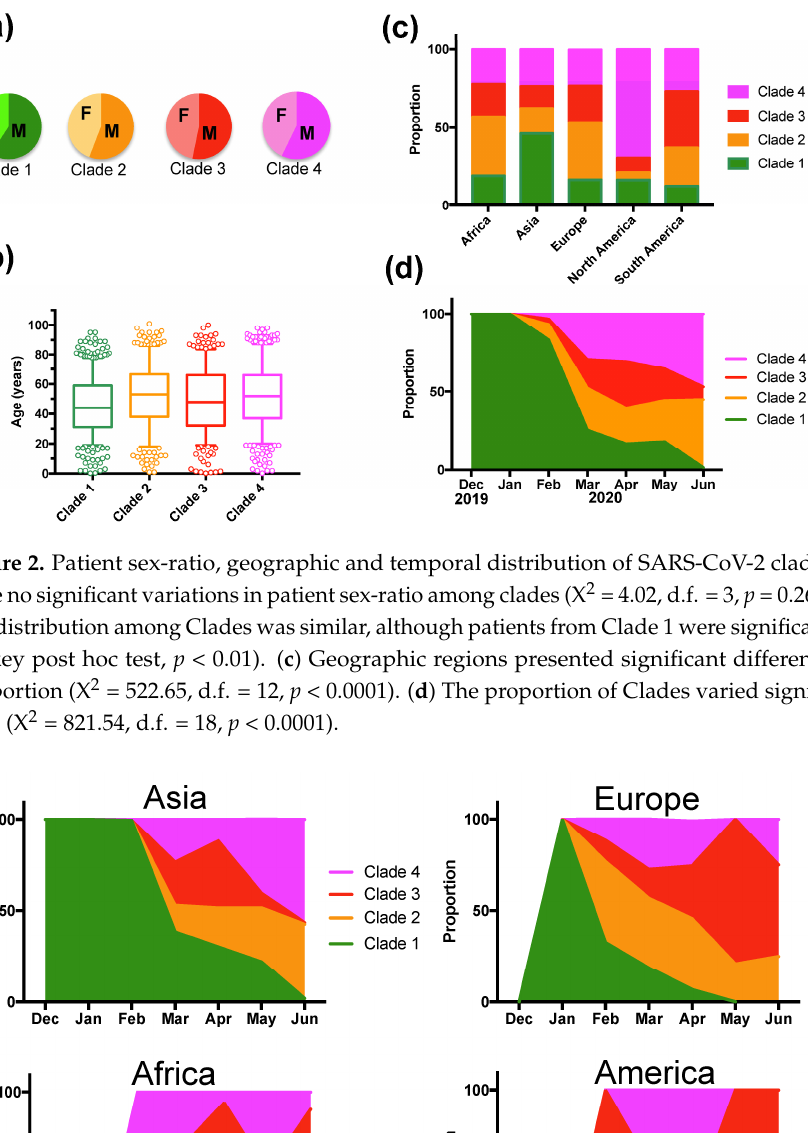
Figure 1. Genomic diversity of SARS-CoV-2 and patient mortality. Phylogenetic analysis of SARS- CoV-2 genomes from 2508 patients. The unrooted tree showed four main Clades (Clades 1–4) with a strong phylogenetic support as specified for each major branch, and mortality rates varied signifi- cantly among Clades as indicated (X 2 = 47.93, d.f. =3, p < 0.0001). GISAID clade names are indicated in parenthesis for comparison.